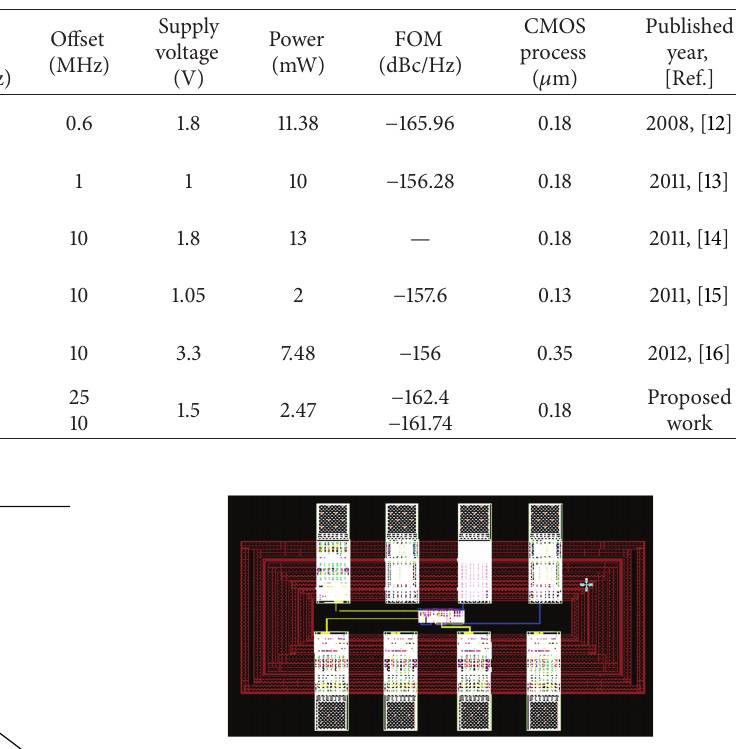
Table 1: Performance comparisons of CMOS ring-VCO.